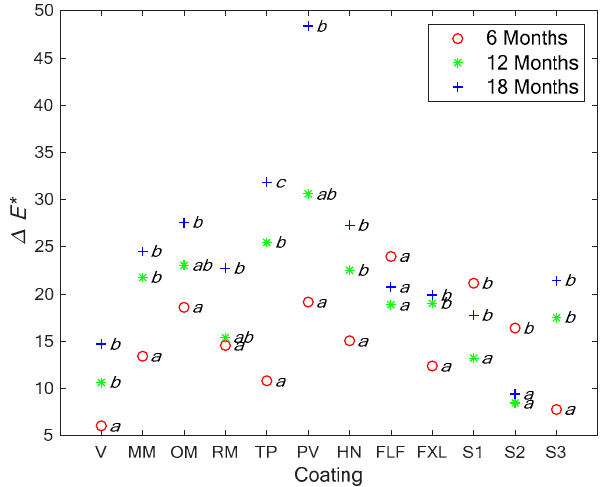
Figure 15. Games–Howell pairwise mean differences of color change for western redcedar wood for each coating during the study. Superscripts with the same letter indicate means between intervals that are not significantly different at the p < 0.05 level.